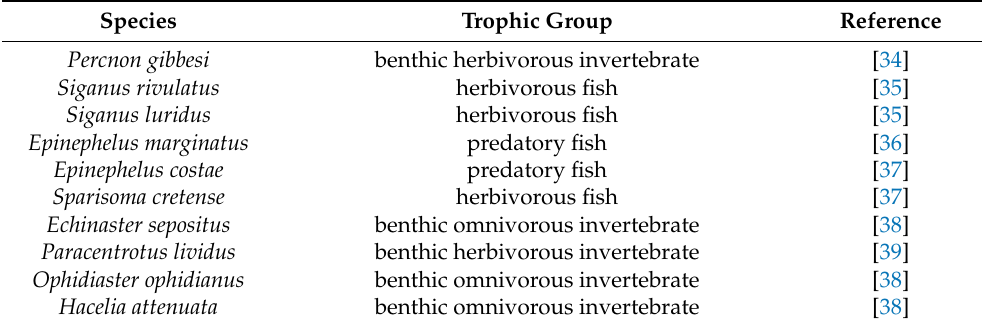
Table 2. Assignment of targeted species to trophic groups based on relevant scientific literature regarding species